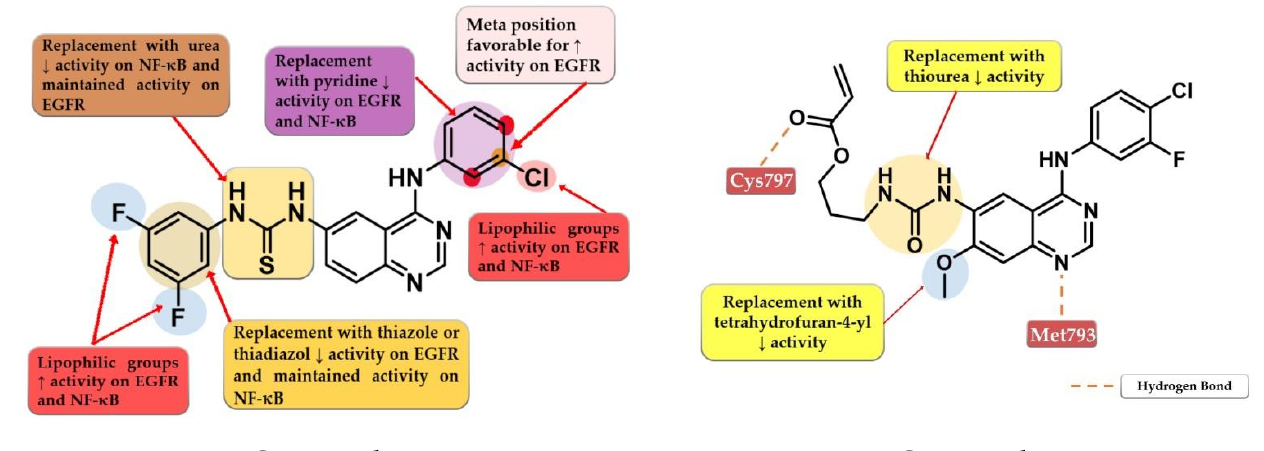
Figure 6. Structure–activity relationship of compound 7 as reported by Hamad et al. [111]; structure–activity relationship and molecular docking of compound 8 in the human EGFR T790M kinase domain (PDB ID 4G5J) [108], as reported by Gan et al. [112].